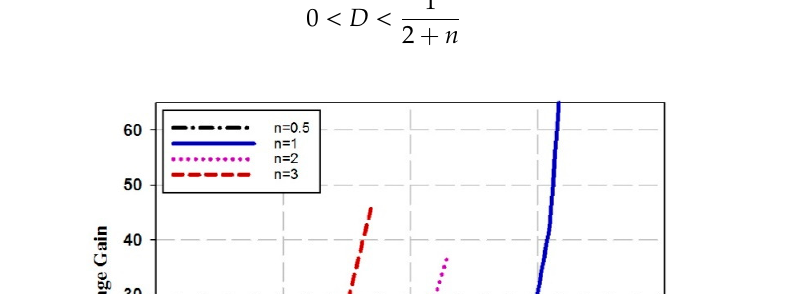
Figure 7. Voltage gain of the proposed converter vs. converters in [12,18,19].